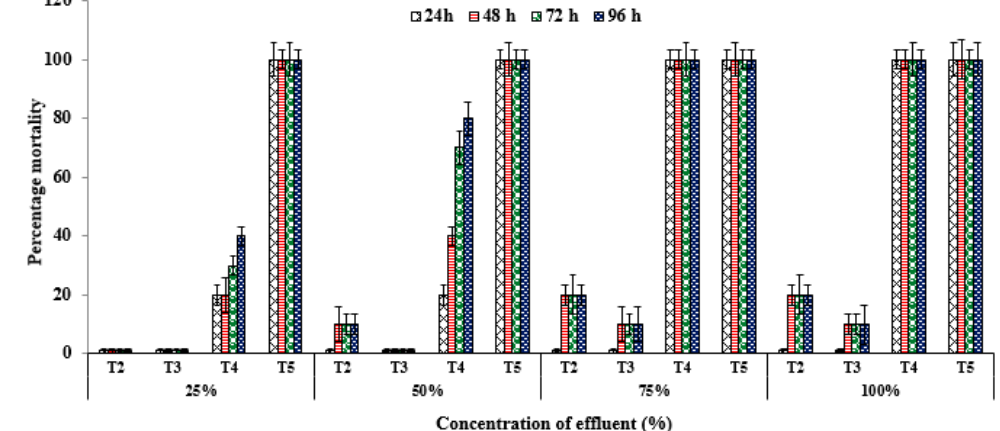
Figure 1. Mortality in fish on exposure to di ff erent concentrations of untreated and treated e ffl uent by CWs using Typha domingensis. Tannery e ffl uent treated in CWs with only T. domingensis (T2), e ffl uent treated in CWs with T. domingensis and bacteria (T3), e ffl uent treated in CWs without vegetation (T4), effluent treated in CWs with T. domingensis and bacteria (T3), effluent treated in CWs without and raw tannery e ffl uent (T5). Each value is mean ± standard error and number of replicates for each vegetation (T4), and raw tannery effluent (T5). Each value is mean ± standard error and number of treatment ( n ) = 3. Processes 2020 , 8 , x FOR PEER REVIEW